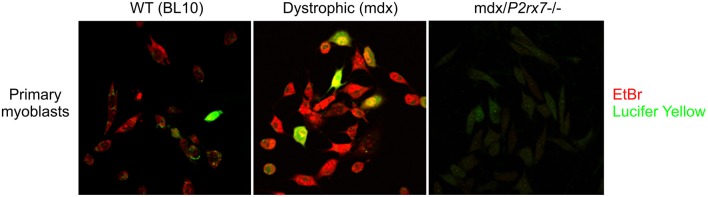
Selective regulation of cationic and anionic dye permeation through the P2RX7 LP. Example of differences in P2RX7 LP permeation preferences to EtBr (cationic) and Lucifer Yellow (anionic) dyes in individual cells of a clonal population (Young and Gorecki, 2016): Compared to WT myoblasts (Left), the dystrophic mdx myoblasts (Center) display upregulated P2RX7 expression and increased LP permeability in response to eATP (Young et al., 2015, 2017). The mdx/P2RX7−/− myoblasts (Right) show no dye uptake under these conditions, as expected. Note that the majority of the seemingly identical cells in this clonal population shows a clear preferential uptake of EtBr over LY upon the LP opening, which is considered to be a non-selective pore. The molecular mechanisms underlying this phenomenon are currently under investigation as this experiment illustrates the potential for diverse LP responses in heterogeneous and functionally plastic populations of e.g., immune cells in vivo.